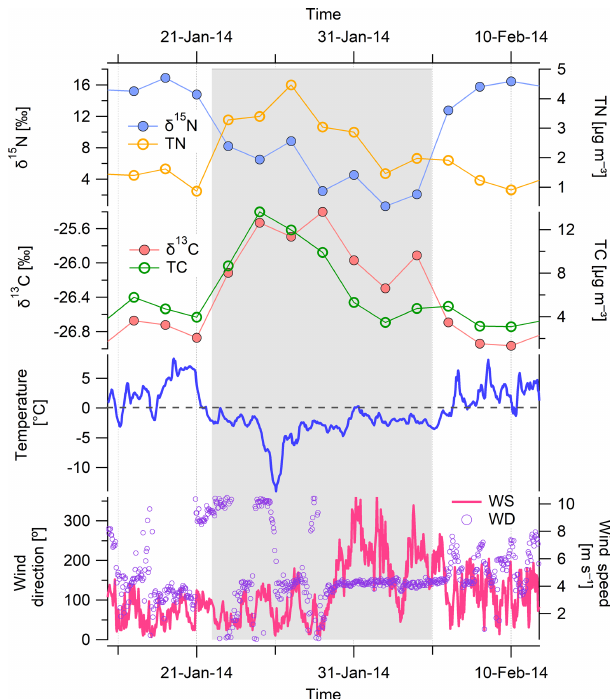
Figure 9. Time series of δ 15 N, TN, δ 13 C, TC and meteorological variables (temperature, wind speed and direction, and 1h time res- olution) during the event, which is highlighted by the gray